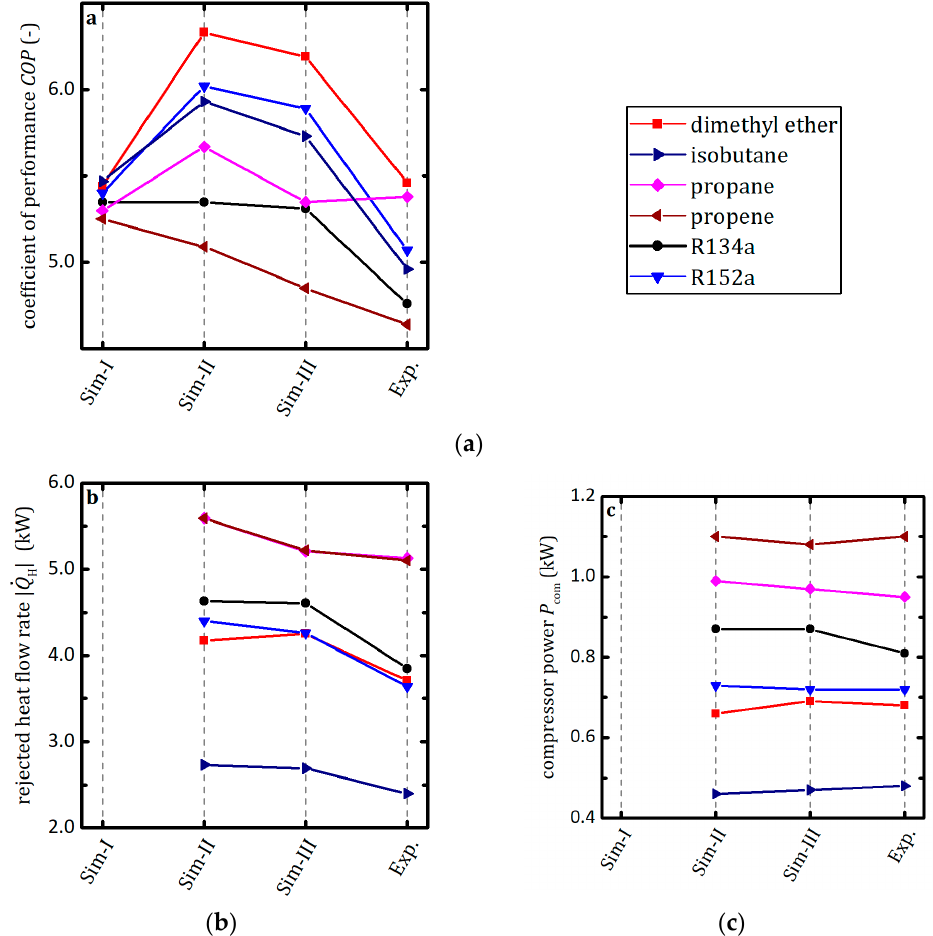
Figure 2. Coefficients of performance ( a ), rejected heat flow rates ( b ) and compressor power ( c ) for different fluids and for three simulation levels and the experiments.